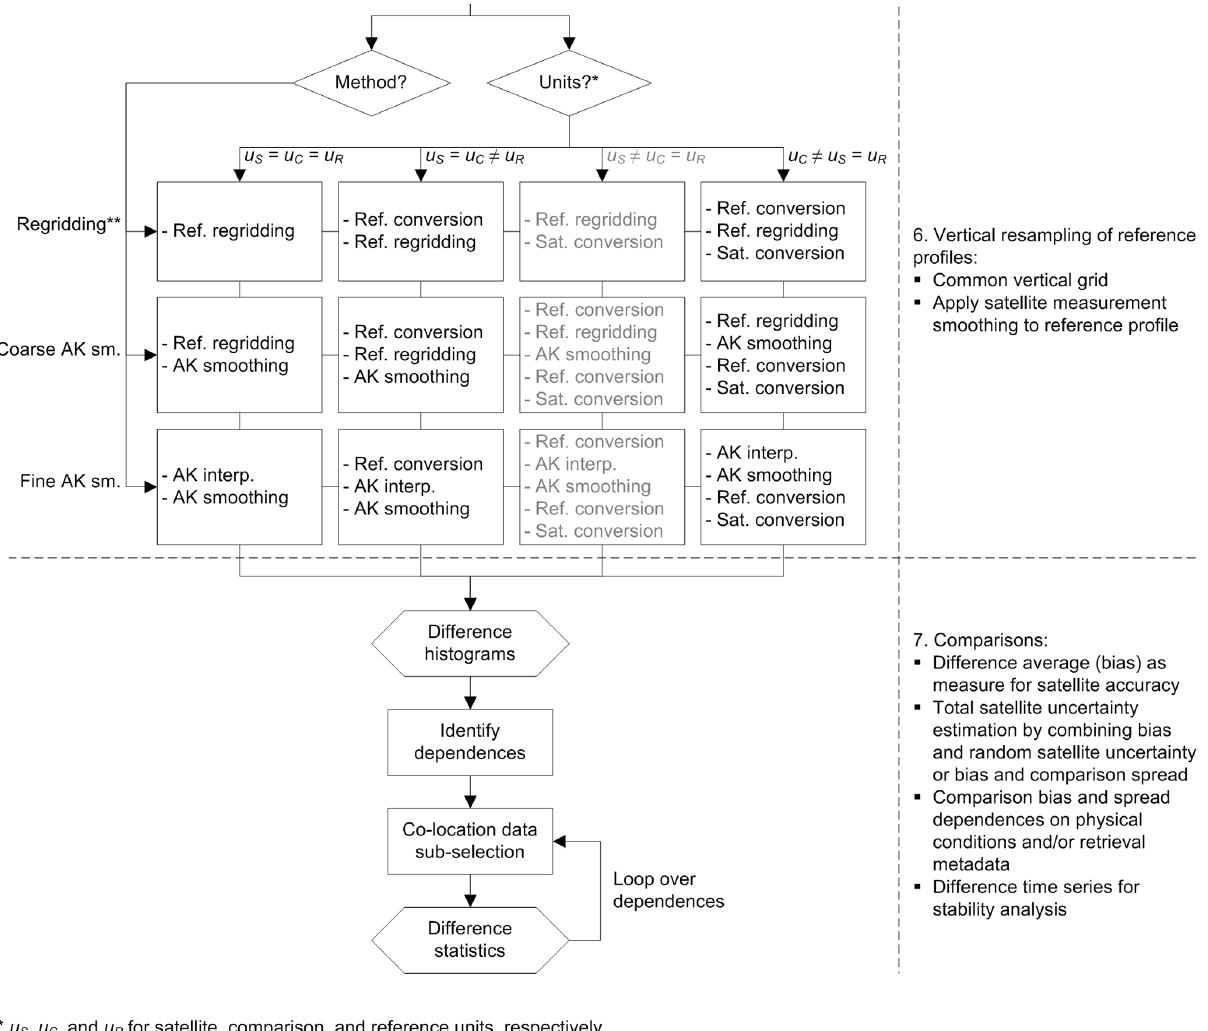
Figure A1. Nadir ozone profile retrieval round-robin evaluation flowchart. The unit option marked in grey is not of use in this